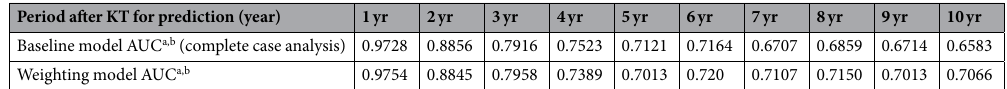
Table 4. Comparison of AUC values between baseline model (only with uncensored data) and weighting model in decision-tree modeling for classification problem. a Setting 1: Use overall attributes with multiple imputation, b Instance weighting methods by Zupan et al . 6 ; yr,